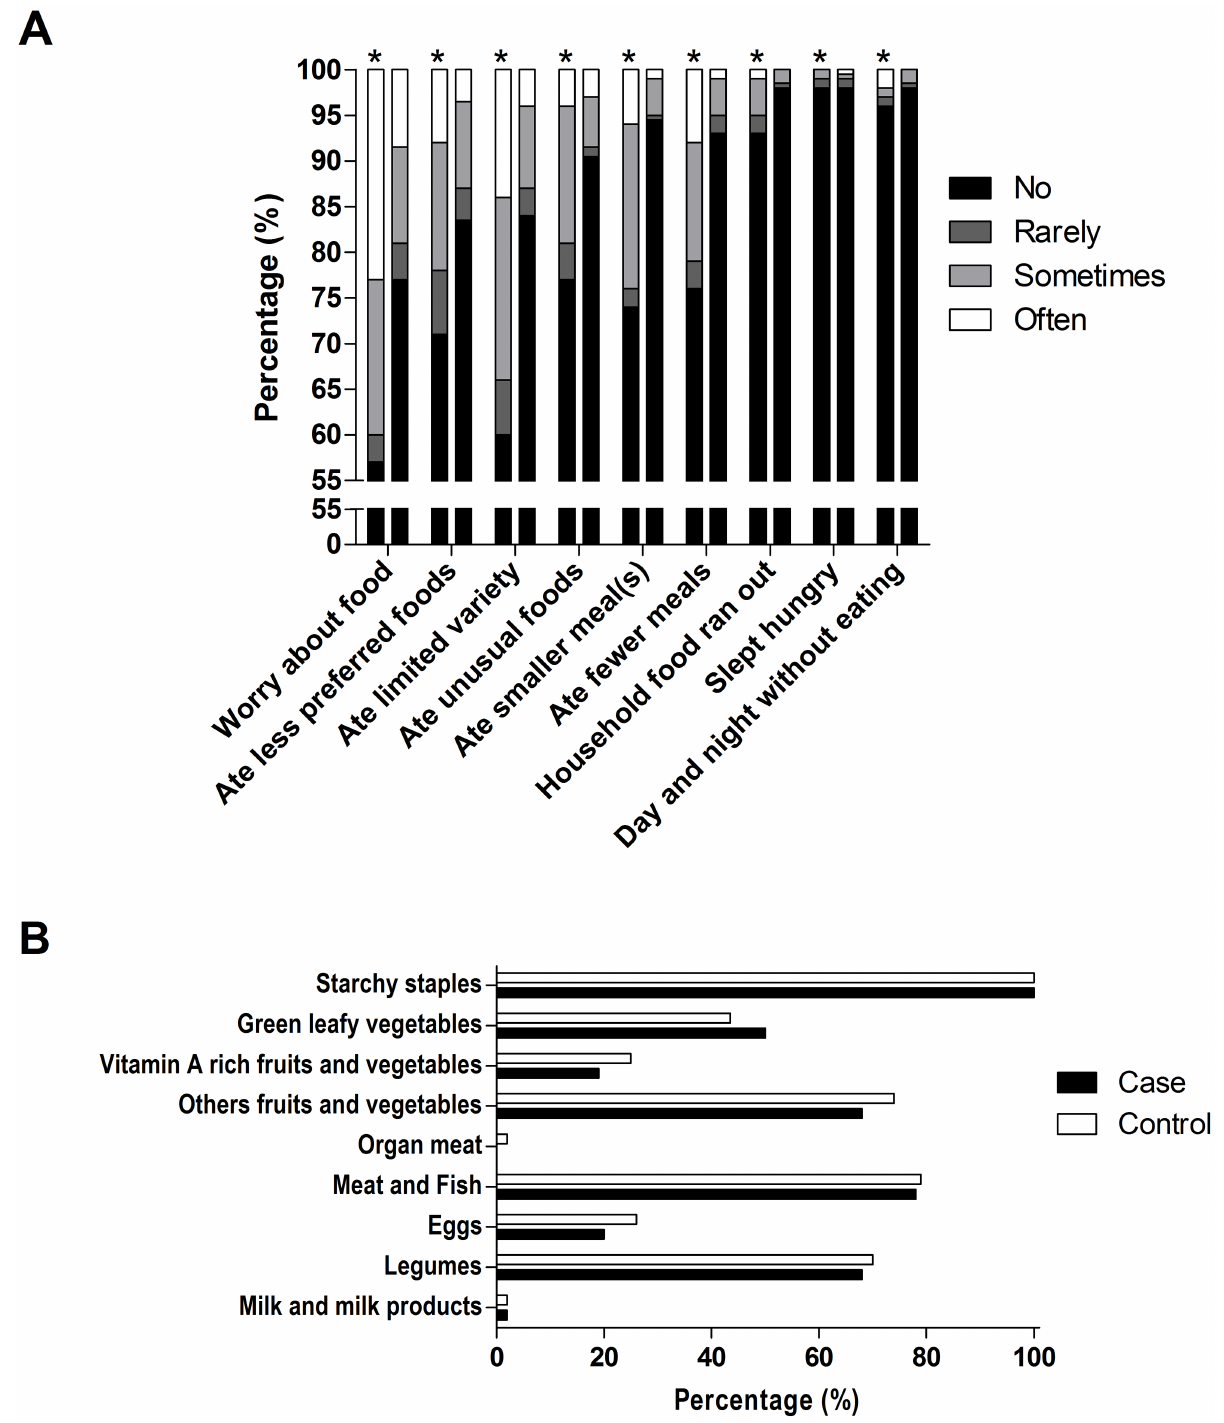
Fig 2. Comparison of the frequency-of-occurrence of each HFIAS item (A) and the IDDS profile (B) between the cases and controls.